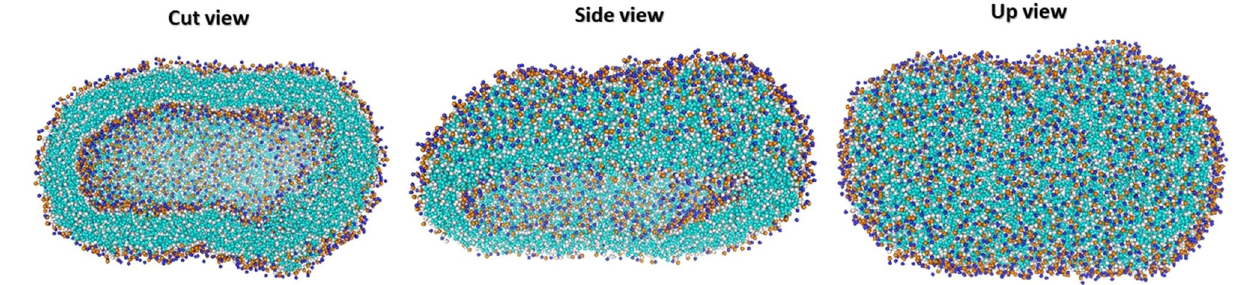
Figure 5. Schematic of the formation of the liposomal model (vesicle) structure in the three different views. Trajectory snapshots from a DOPC–DOPE system that taken after 2100